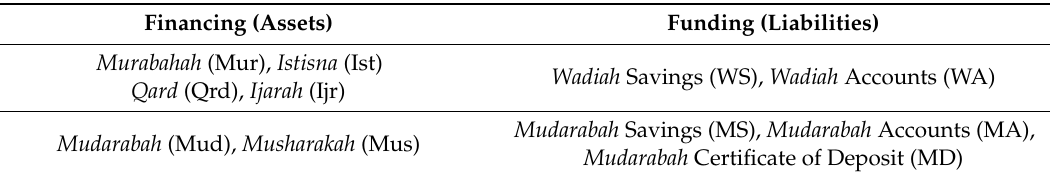
Table 1. The balance sheet of a Sharia